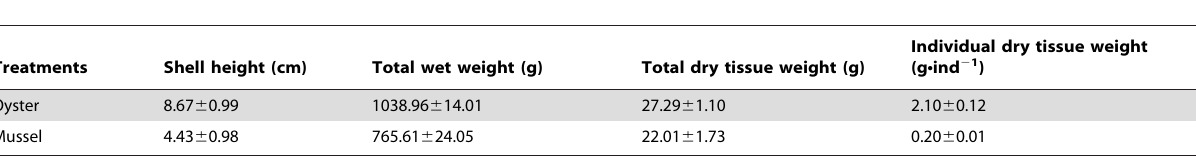
Table 1. Biological parameters of bivalves used in the experimental systems.